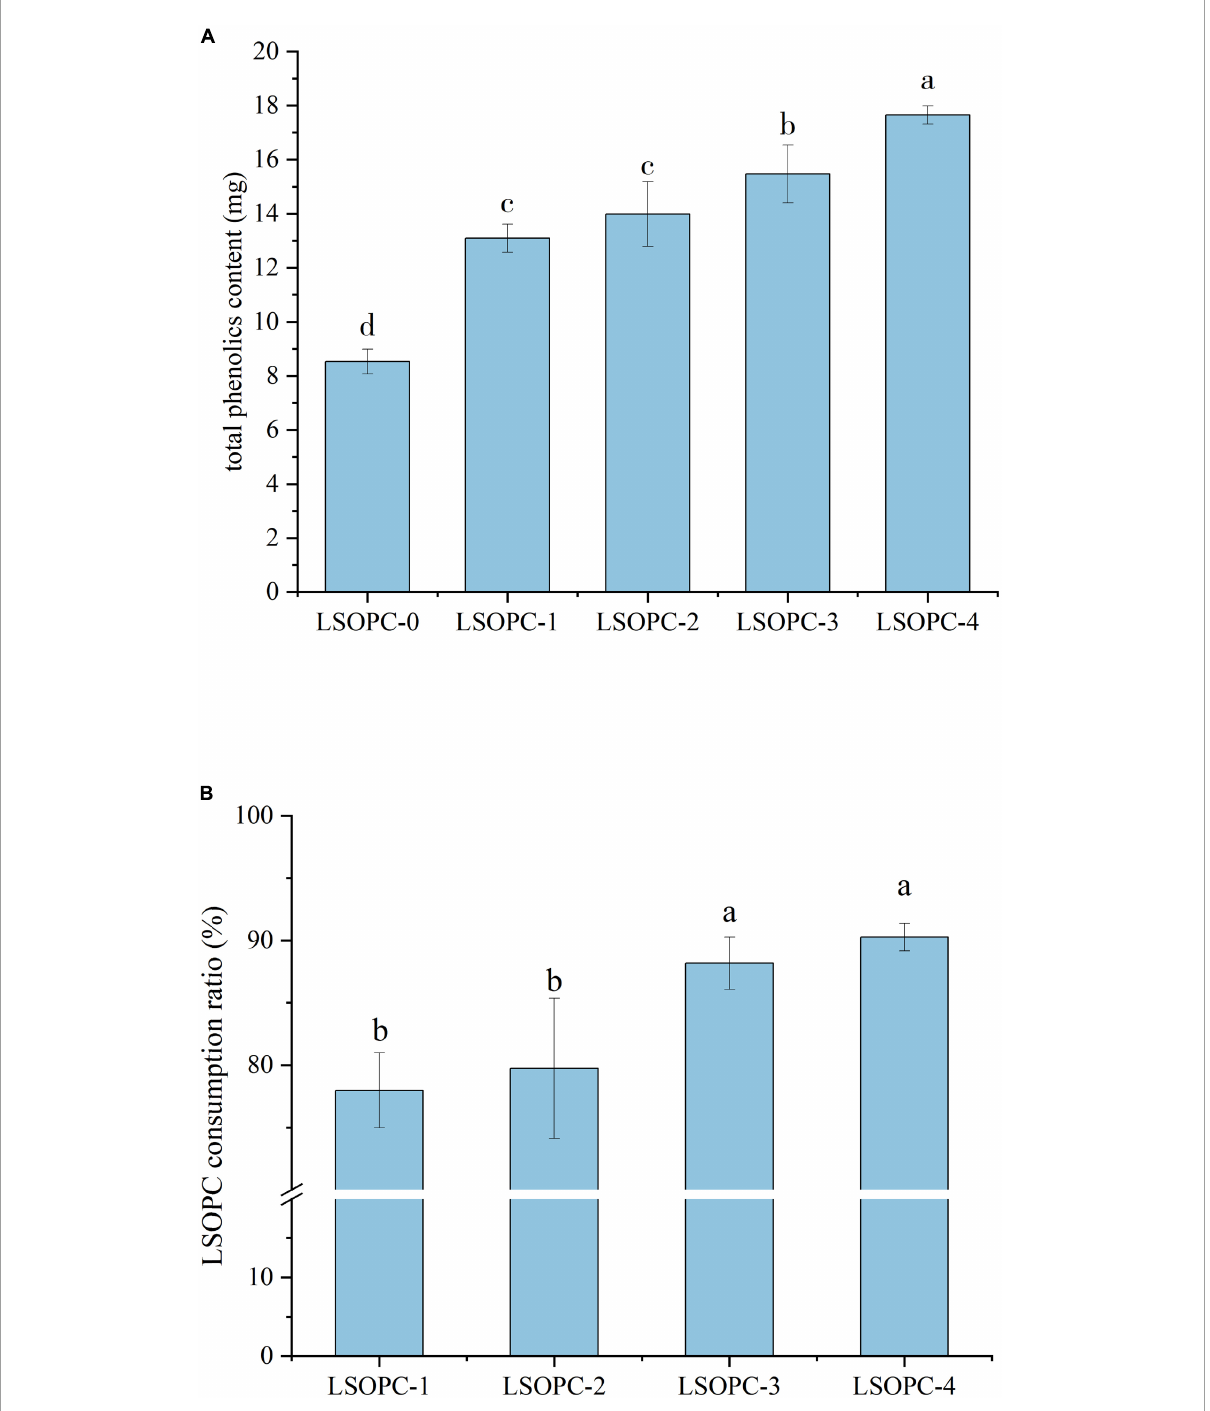
FIGURE2 Effect of different concentrations of LSOPC on total phenol content in cookies (A) . Effects of different concentrations of LSOPC on its consumption ratio in cookies (B) . Significant differences ( p < 0.05) of data values are indicated by different letters.